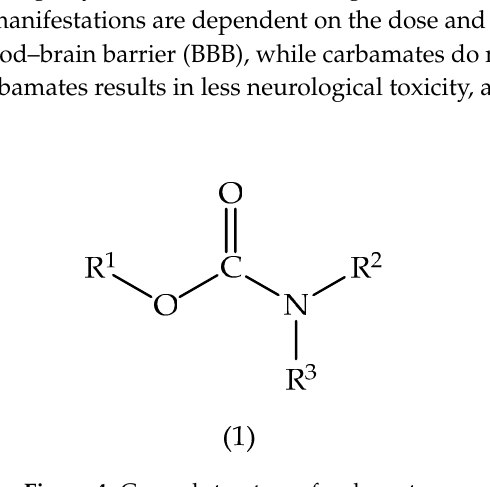
Figure 4. General structure of carbamates.